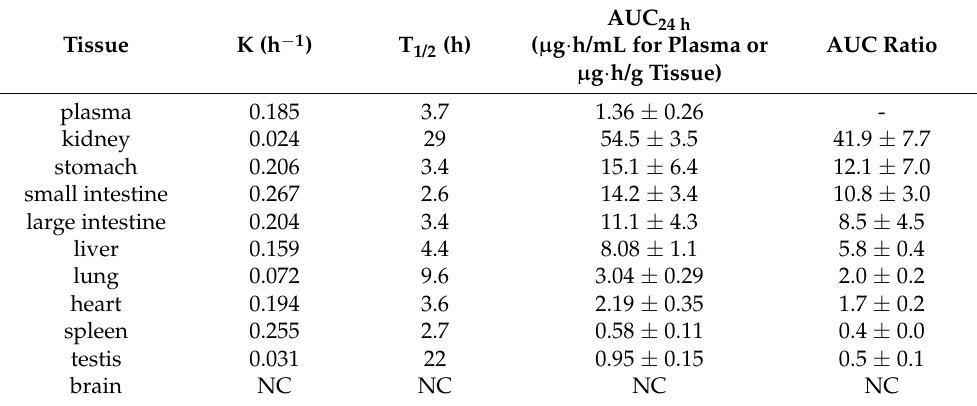
Table 6. Elimination constant, elimination half-life, and AUC of enavogliflozin in various tissues after single oral doses (1